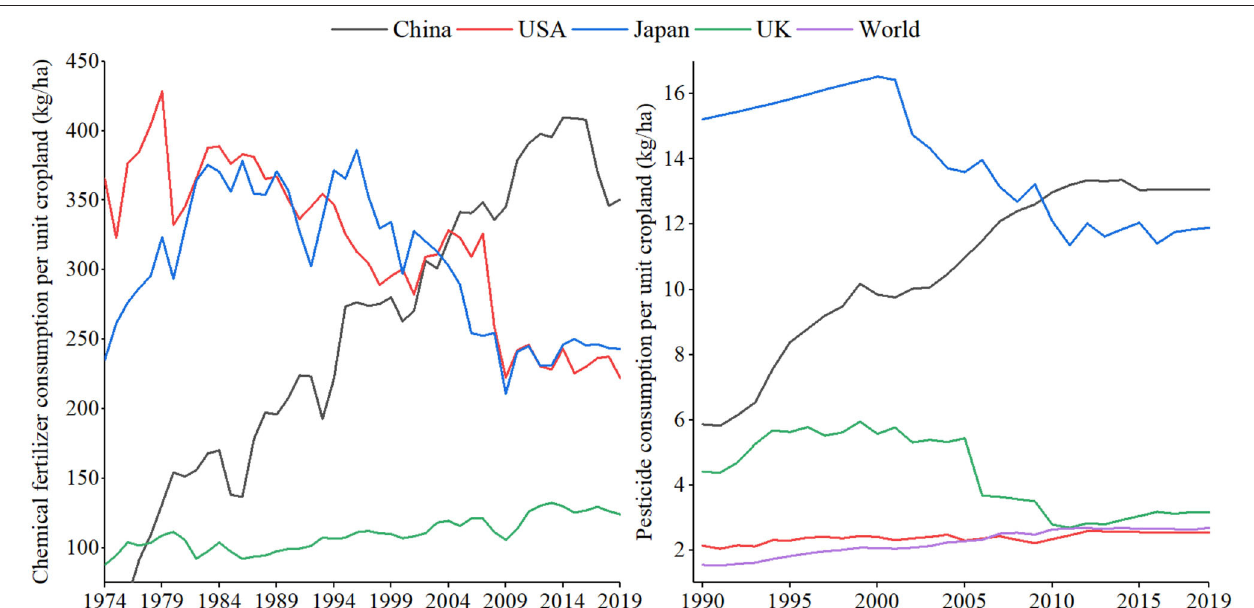
FIGURE 2 | The chemical fertilizer and pesticide consumption intensity in selected countries. Data source: Statistics Division of the Food and Agriculture Organization.